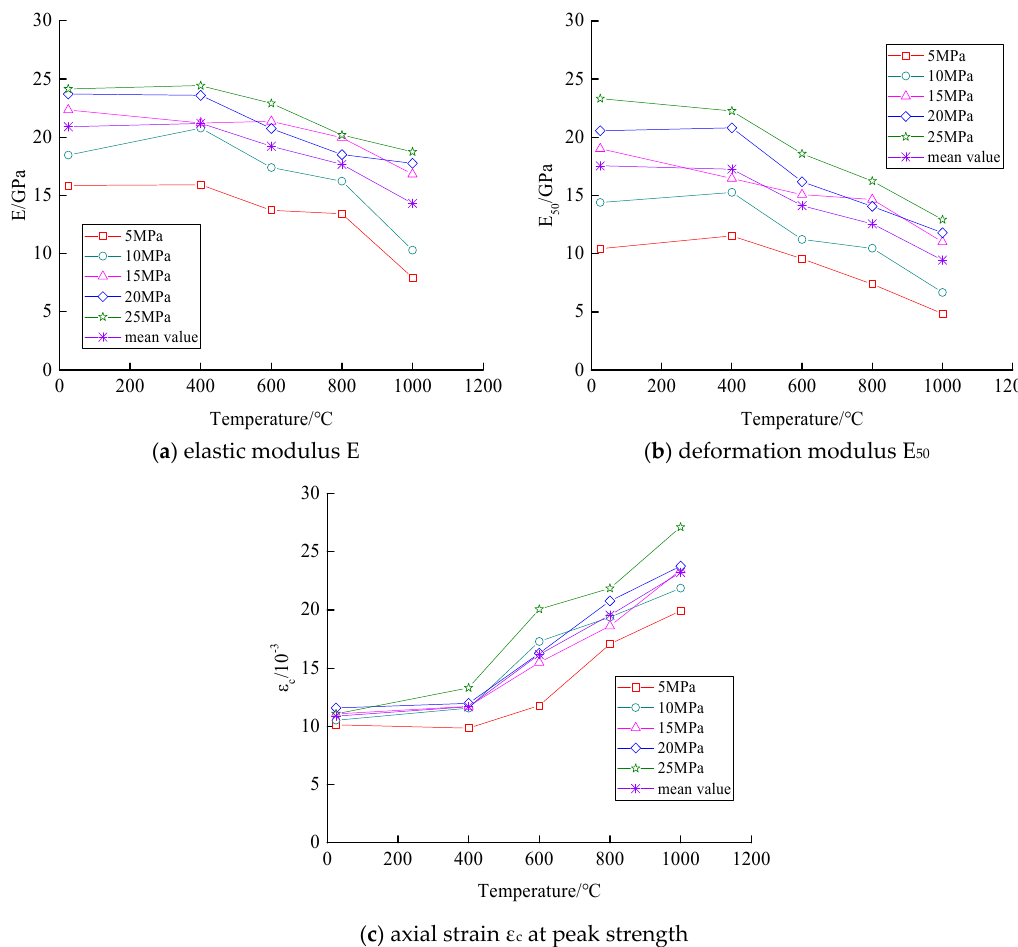
Figure 13. Relationship between temperature and deformation parameters of triaxial compression test.